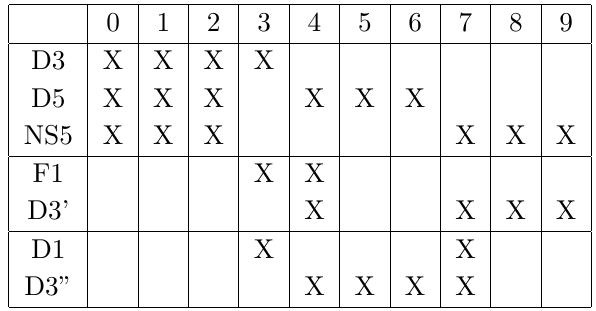
Table 2 . Brane array for 3d N = 4 theories and half-BPS local